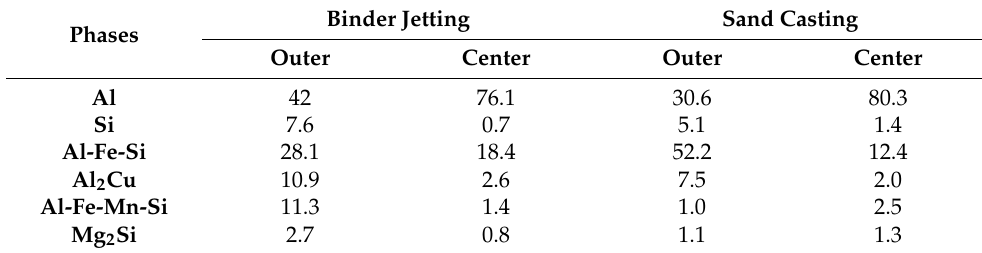
Figure 5. Experimental XRD patterns of the aluminum-silicon alloy processed by sand and binder jetting mold. ( * Al; Si; Table 2. Semi-quantitative results for the samples solidifies in both molds (sand mold and binder jetting